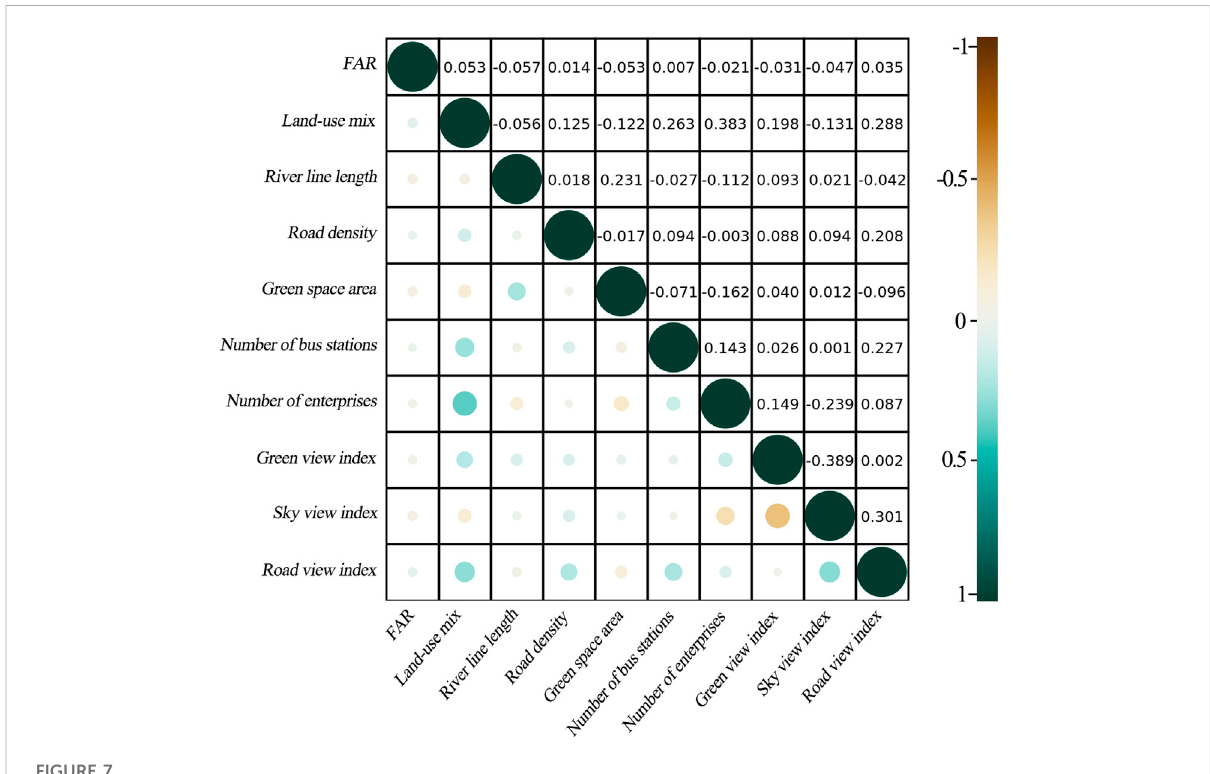
FIGURE 7 Pair-wise Correlation analysis results.